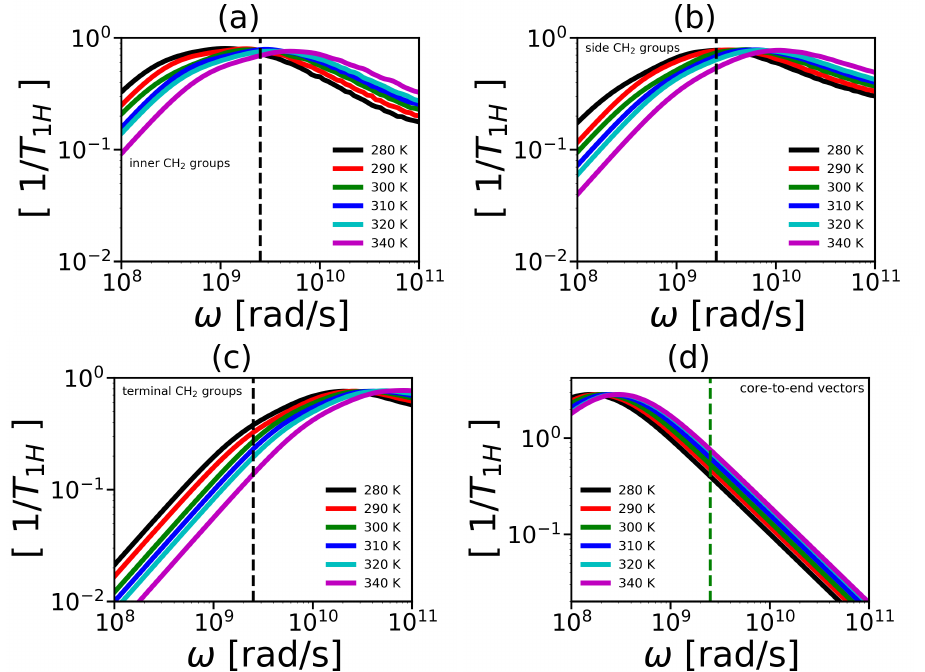
Figure 10. The frequency dependencies of [ 1/ T 1 H ] for ( a ) inner, ( b ) side, ( c ) terminal CH 2 groups; and ( d ) core-to-end vector. The vertical line correspond to the frequency ω H /2 π = 400